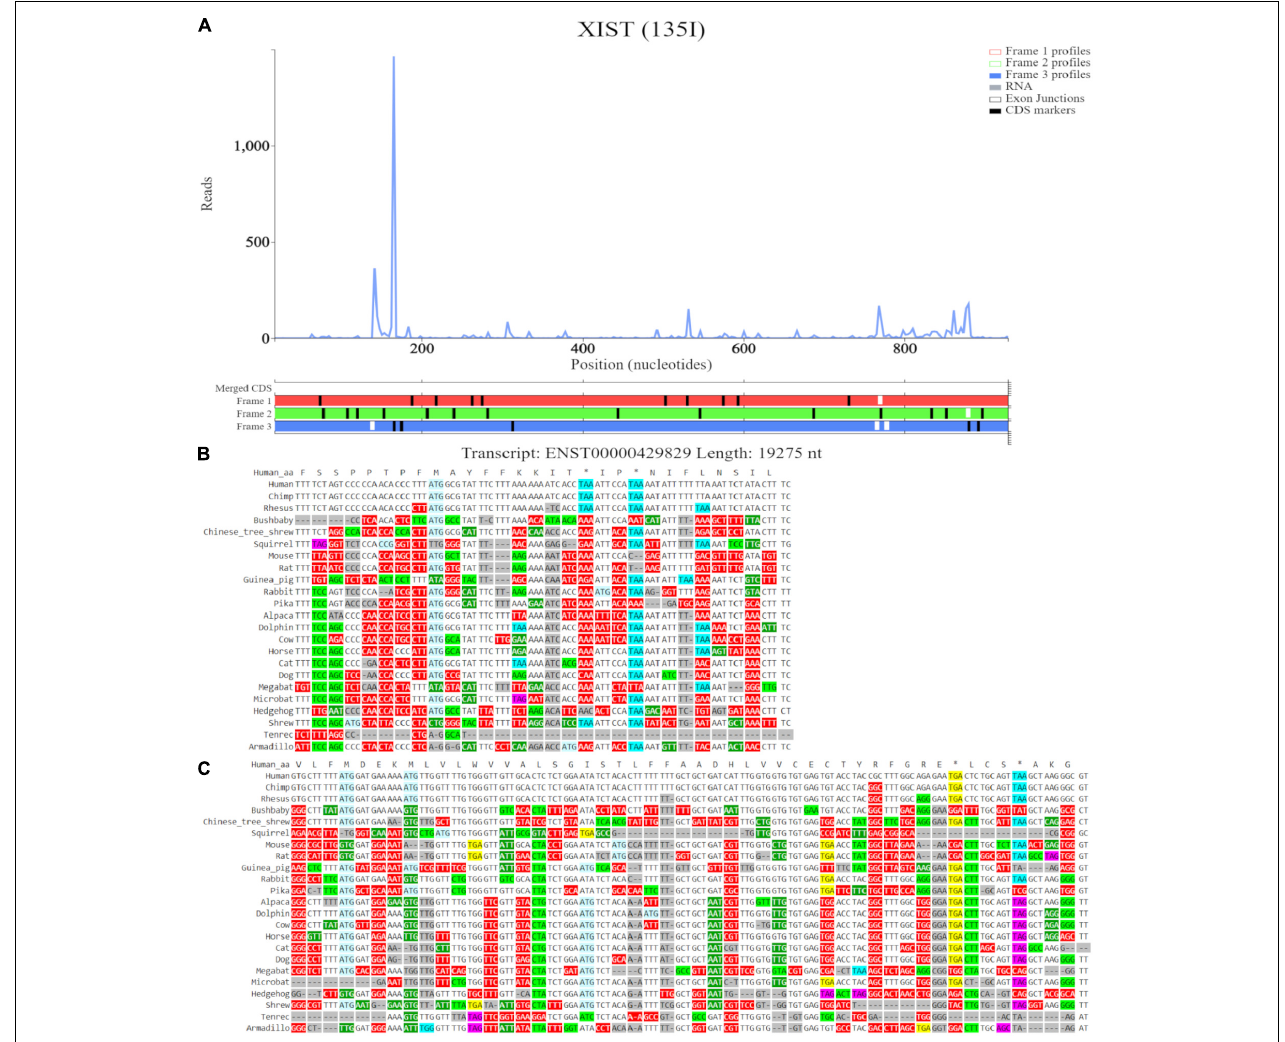
FIGURE 9 | Visualization of XIST in Trips-Viz and CodAlignView. (A) Visualization of transcript ENST00000429829 without RNA-seq data enabled and only reading frame 3 enabled. (B) CodAlignView for the ORF previously outlined in blue showing predominantly absolute codon conservation. (C) CodAlignView for the ORF previously outlined in orange showing mostly absolute codon conservation, there are also more radical non-synonymous codon substitutions than synonymous